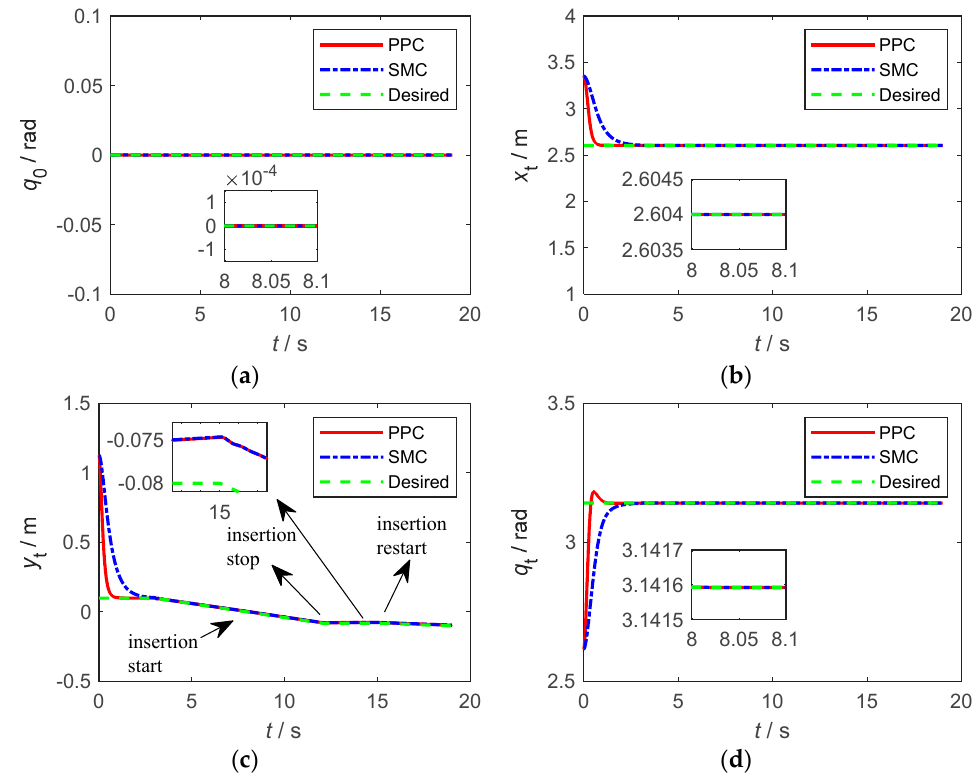
Figure 11. Space robot end trajectory tracking curve of on-orbit insertion operation. ( a ) The carrier attitude. ( b ) The X-direction position. ( c ) The Y-direction position. ( d ) The space robot end attitude.